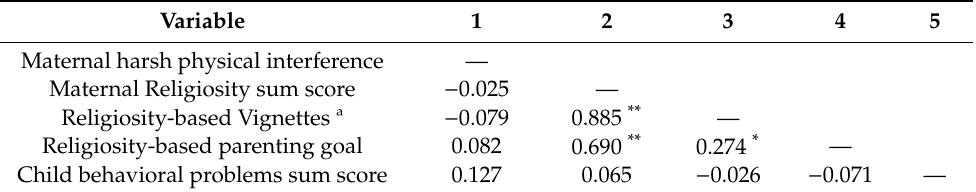
Table 2. Correlations between maternal harsh physical interference, religiosity variables, and child behavioral